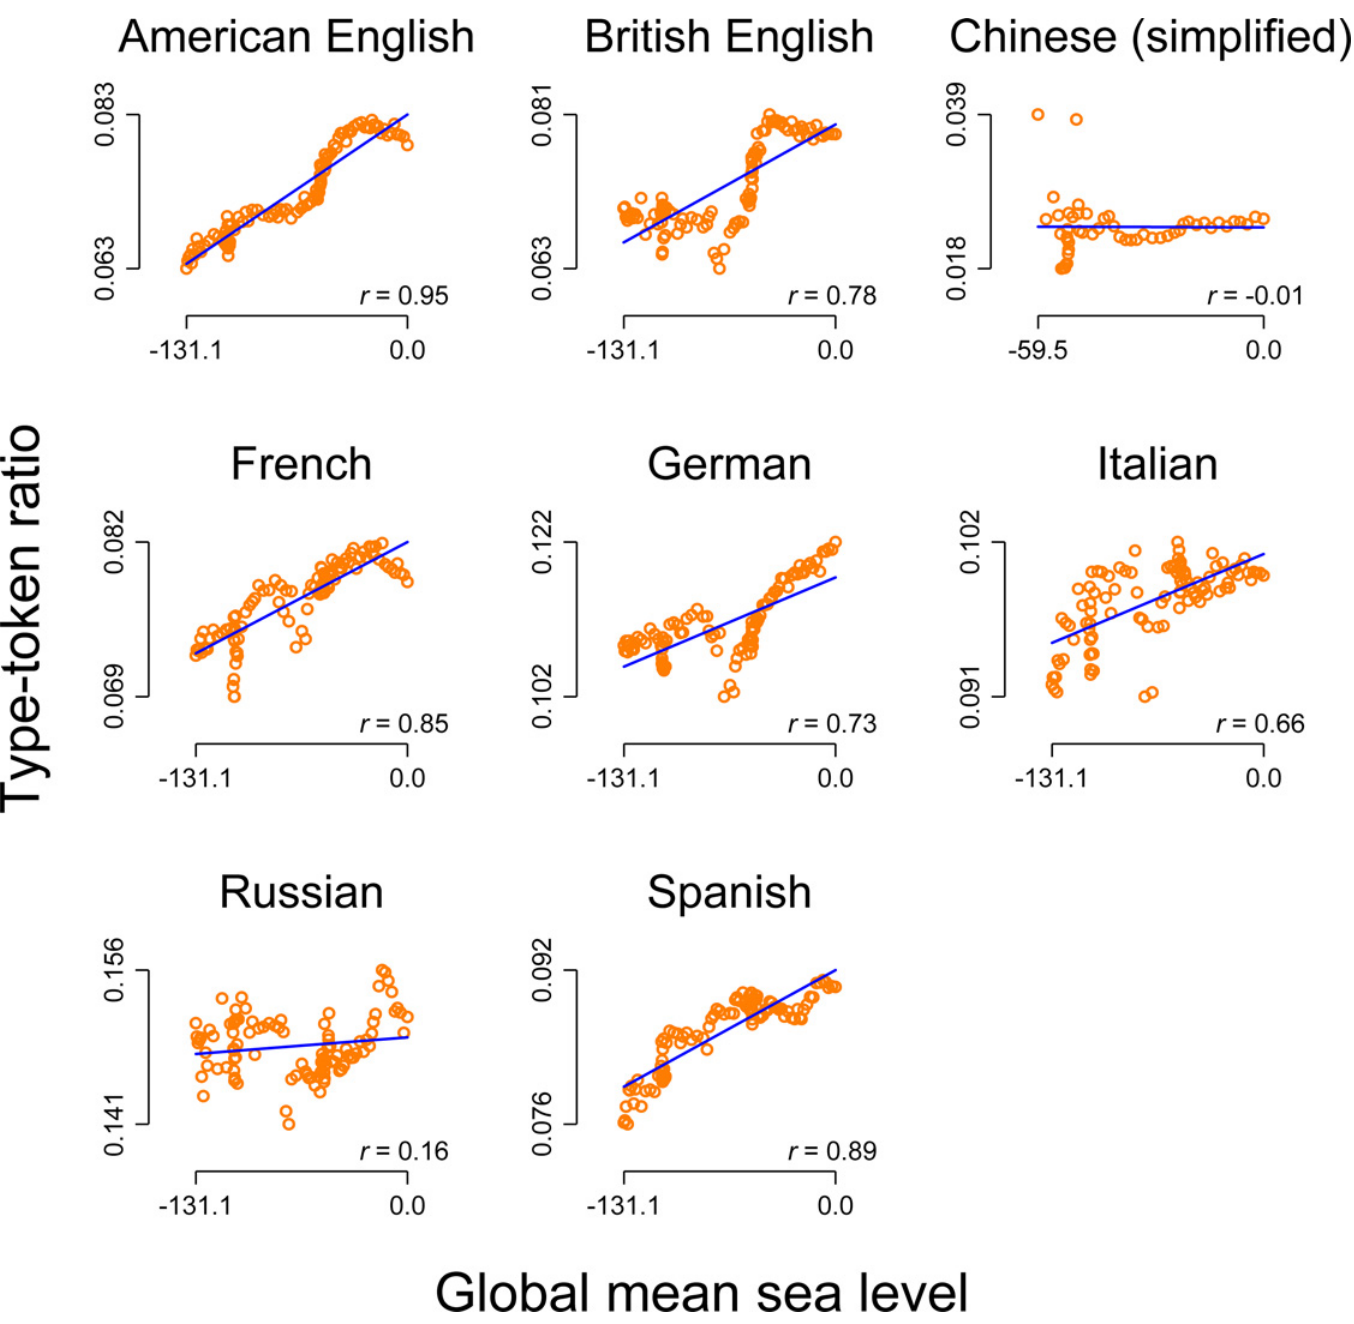
Fig 2. Correlation between the level of the annual global mean seal level and the level of the type-token ratio for eight languages (including two varieties of English). Orange circles: raw data. Blue line: linear prediction of the type-token ratio on the population size. Notes on the bottom right: Pearson correlation (all p s < .001 except for Chinese were p = 0.95 and Russian where p =